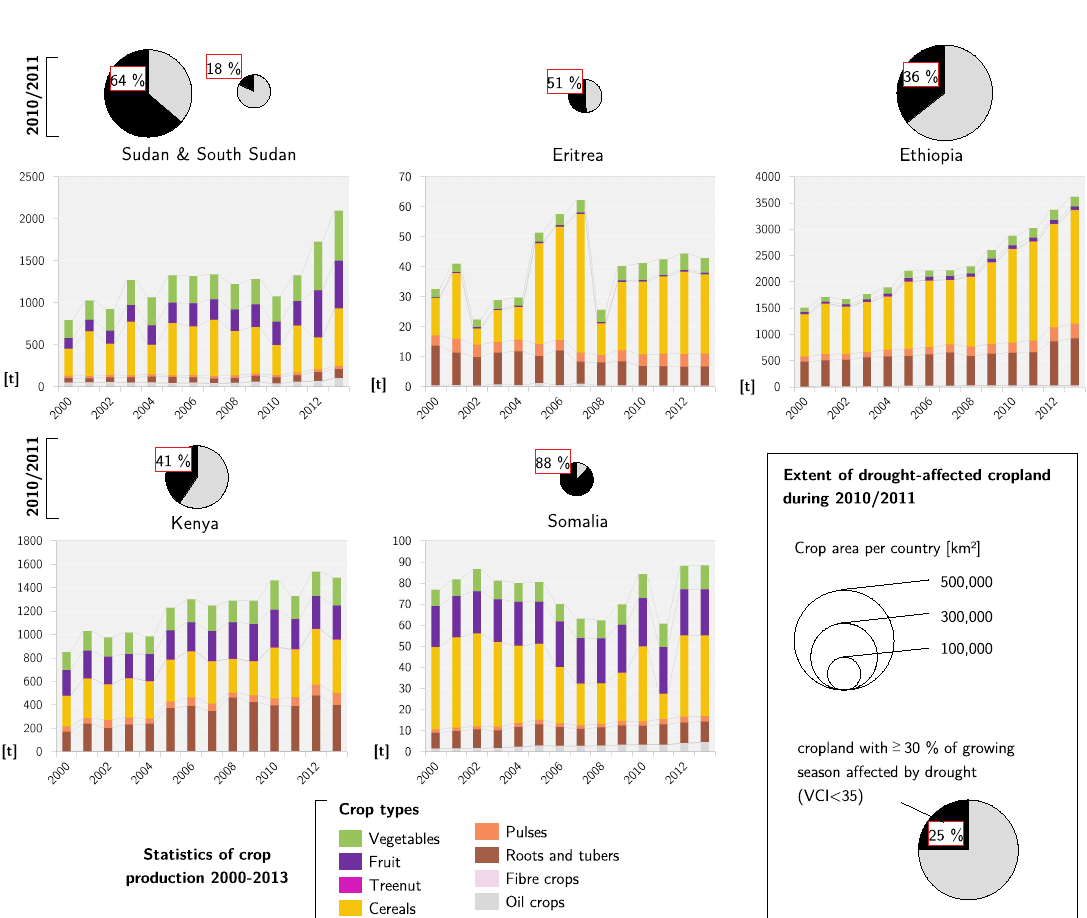
Figure 12. Cropland areas affected by agriculturally relevant droughts in selected East African countries compared with national statistics on annual crop production (Data: FAO